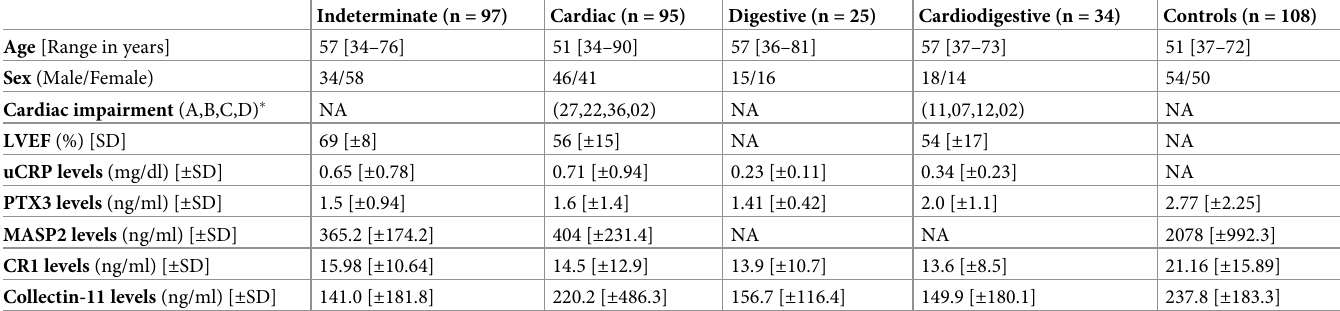
Table 1. Baseline clinical parameters of the investigated study groups.